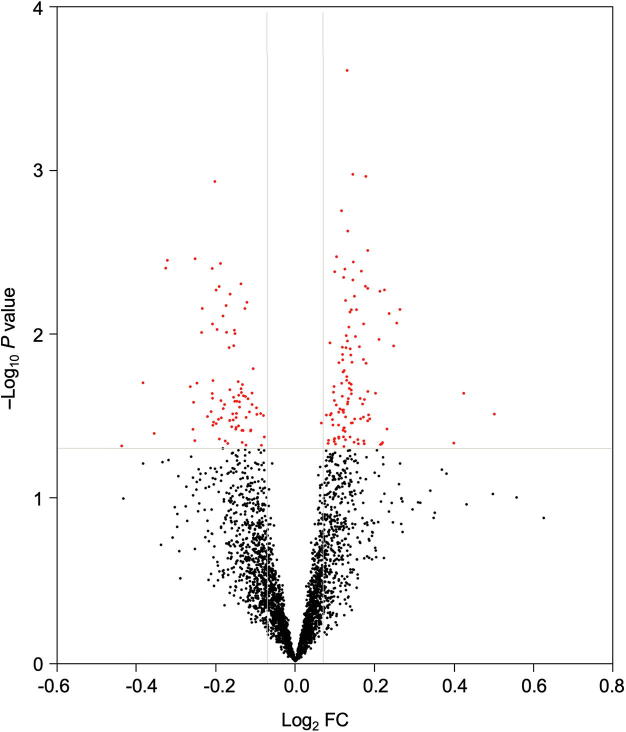
Volcano plot of gene expression in DLPFC (BA46) of schizophrenia versus non-psychiatric controlsThe significance of DEGs (−Log P value) was plotted against their corresponding Log2FC (disease/control) for 37 matched pairs of schizophrenia and non-psychiatric controls. Differential expression was determined using Bayesian empirical linear model (adjusted P < 0.05; FC > 10%). Downregulated genes are shown in top left quadrant and upregulated genes are shown in the top right quadrant with differentially expressed genes (DEGs) highlighted in red. All DEGs are listed in Table S1 with the associated FC and adjusted P values (Benjamini–Hochberg correction). DEG, differentially expressed gene; FC, fold change; DLPFC, dorsolateral prefrontal cortex.